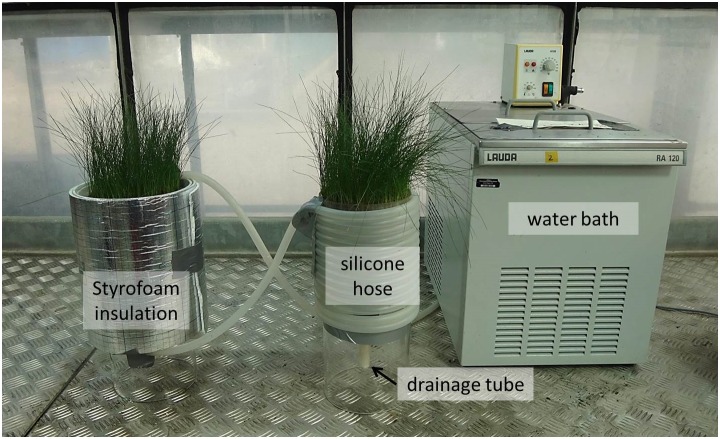
Measurement setup. A water bath is cycling heated or cooled water through hoses wound tightly around each soil monolith with grass swards on top. The styrofoam insulation buffers against external temperature fluctuations.